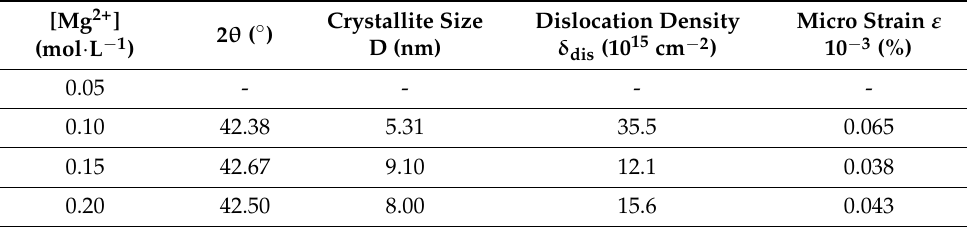
Table 1. Structural parameters of MgO thin layers grown by spray for different magnesium concen-